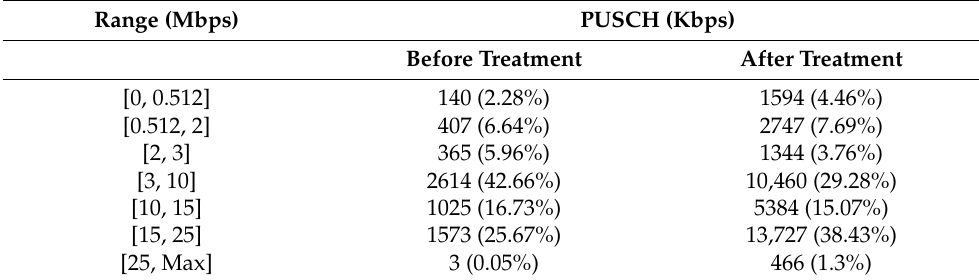
Figure 15. PUSCH physical throughout: ( a ) before treatment; ( b ) after treatment. Table 5. PUSCH physical values before and after treatment.